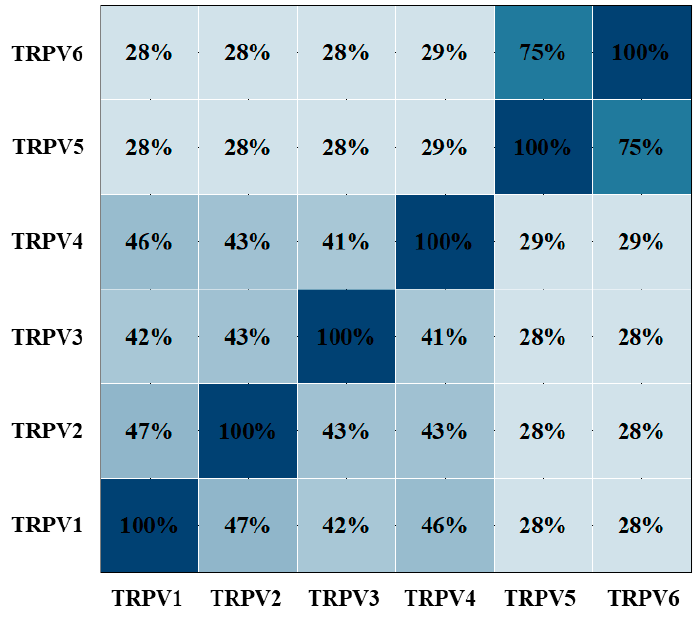
Figure 2. The similarity between TRPV1-6.